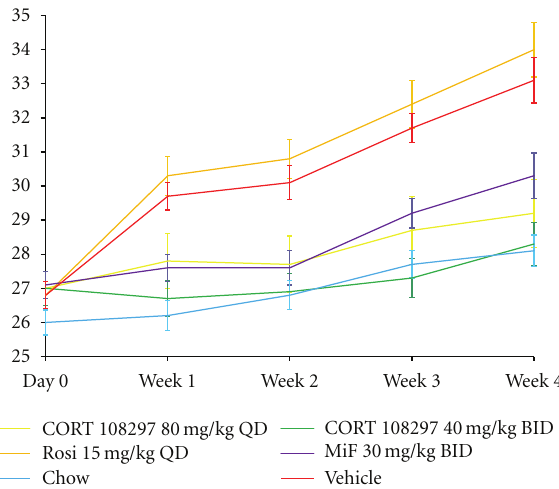
Figure 2: Steady state plasma glucose after 4 weeks. Height of bar represents the mean steady state plasma glucose value at the end of the four-week study. Thin bars indicate standard